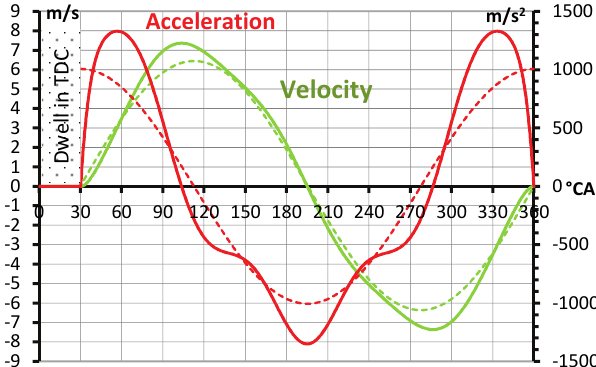
Fig. 8. Calculated velocity and acceleration against the background of the base functions